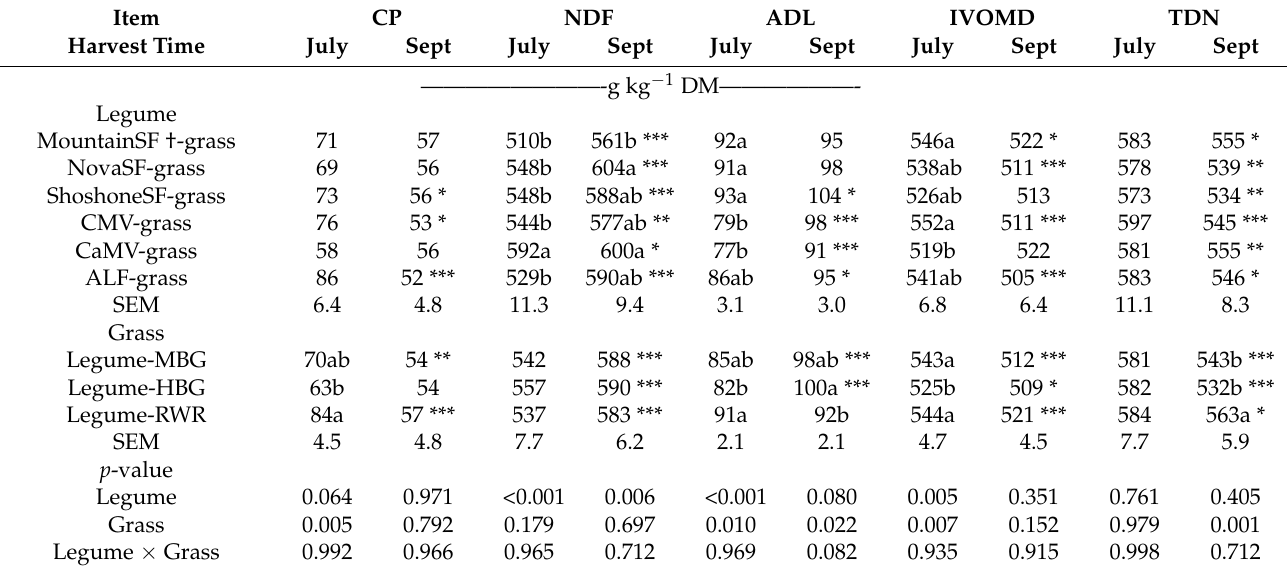
Table 5. Nutrient composition and digestibility of legume-grass binary mixtures at July and September harvest at Swift Current, Saskatchewan,